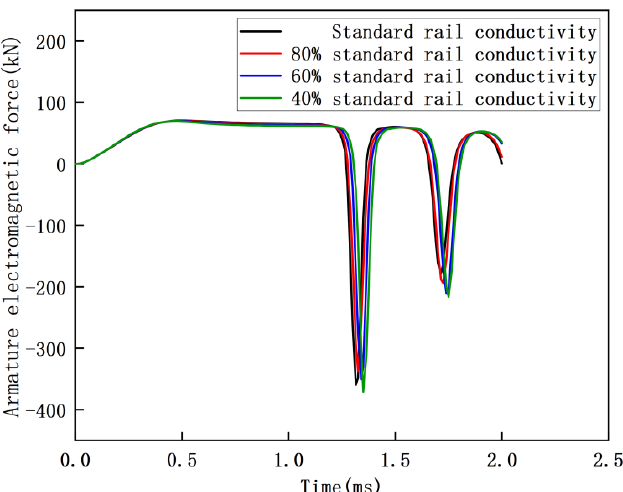
Figure 6. Armature electromagnetic force calculations when only the rail conductivity changes.